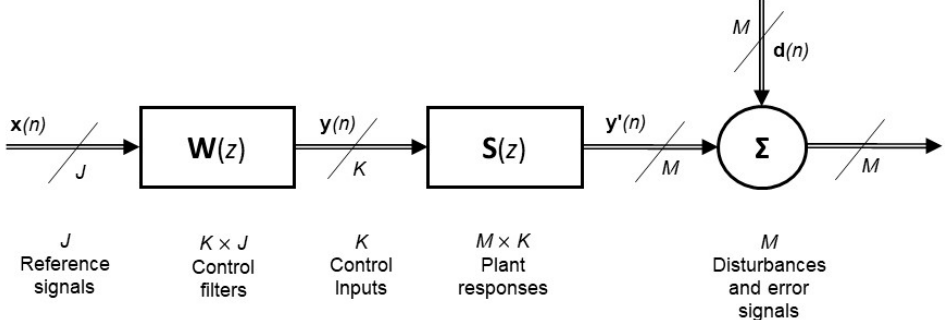
Figure 2. Block diagram of a general multichannel feedforward control with J reference signals, K secondary sources, and M error sensors.